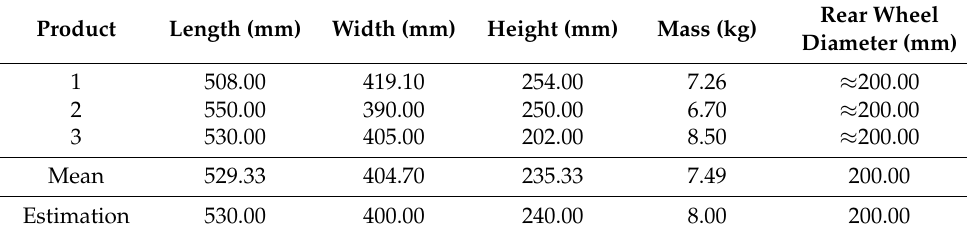
Table 20. Estimation for the size and mass of the multifunctional lawnmower.